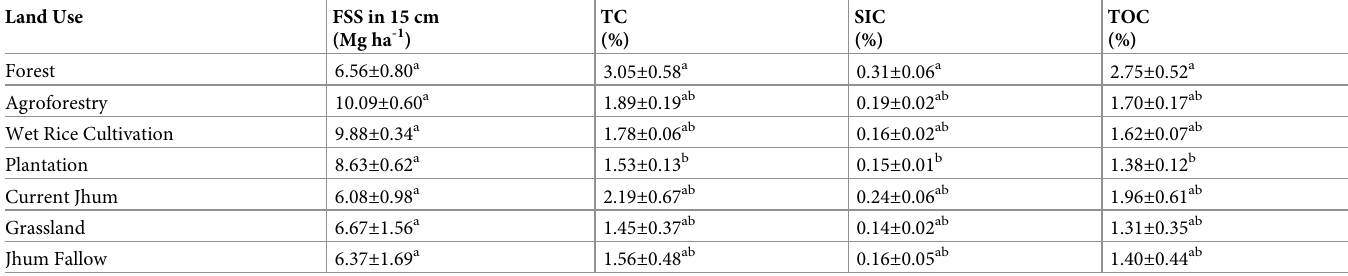
± indicates standard error of mean. Values in same column followed by different letters are significantly different (p < 0.05).